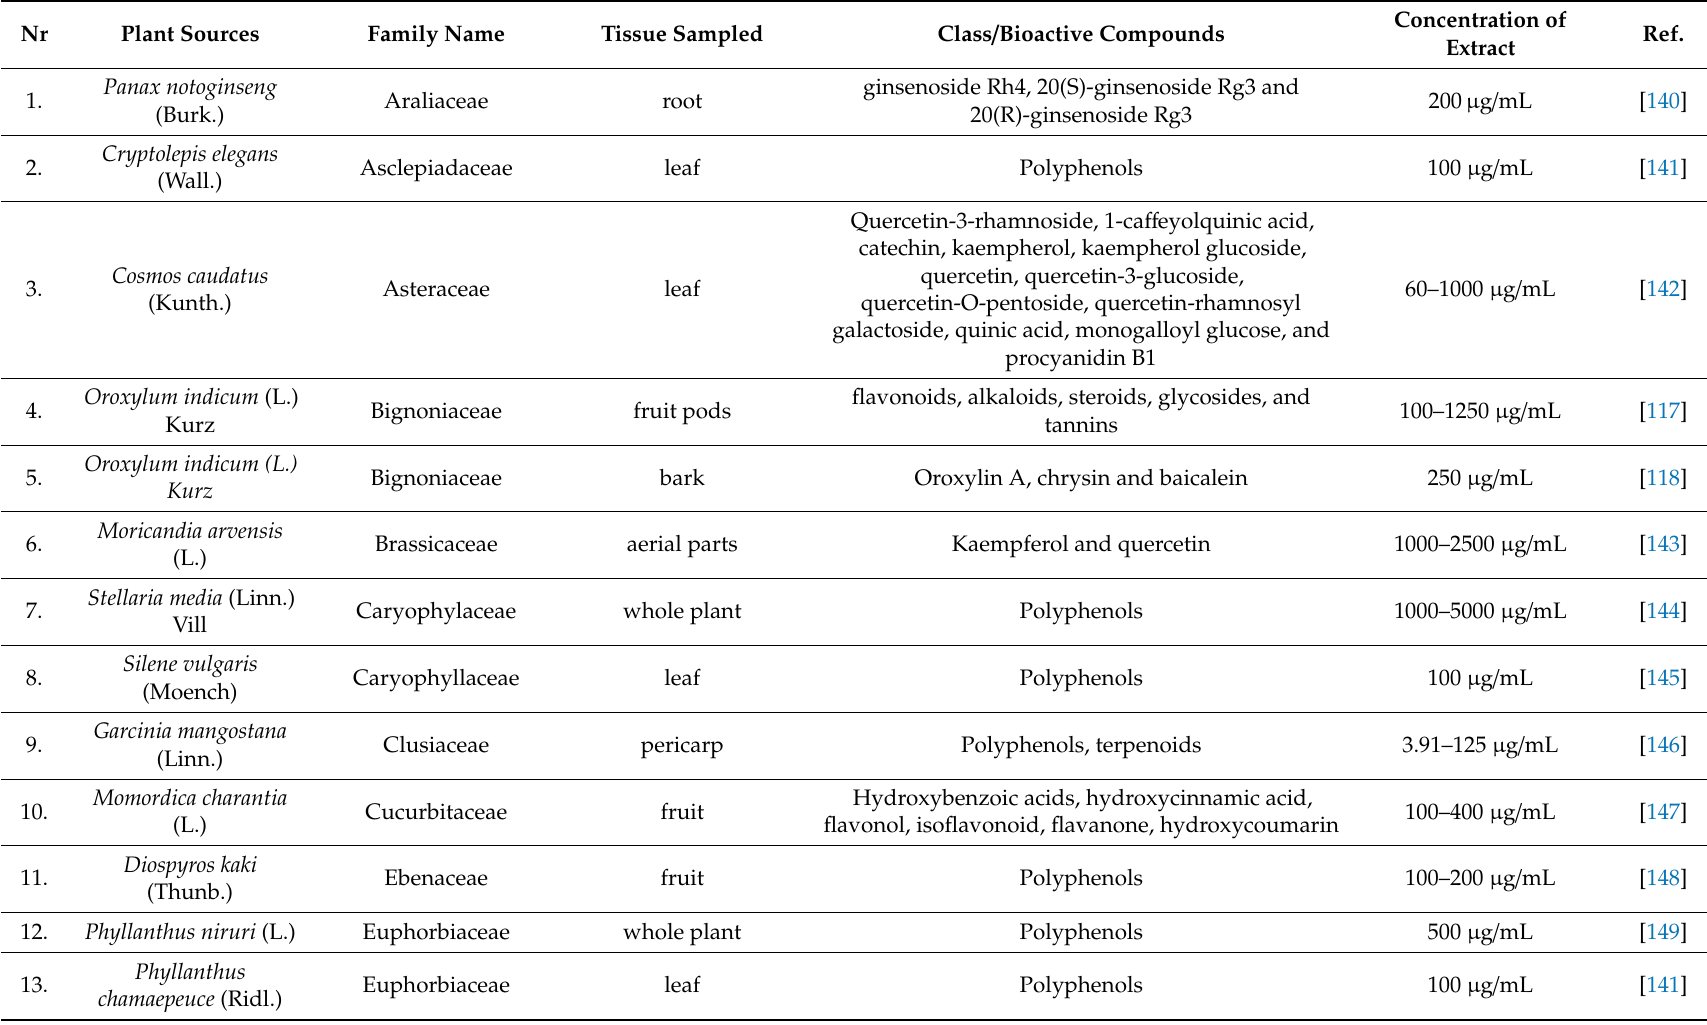
Table 2. Selected plant extract with anti-obesity properties confirmed by porcine pancreatic lipase (PPL) in vitro activity assay with characteristic chemical